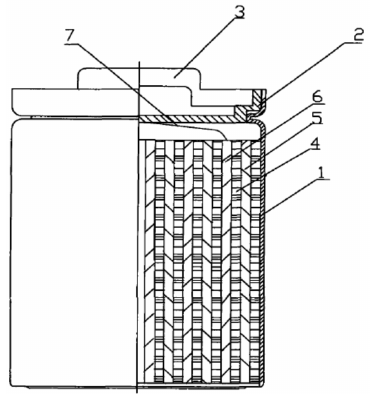
Figure 9. A schematic diagram of a cell with an elongated seal ring and 1: cell wall, 2: sealing ring, 3: vent cap, 4: separator, 5: positive electrode, 6: negative electrode, and 7: tap [91]. 2.6. Kan